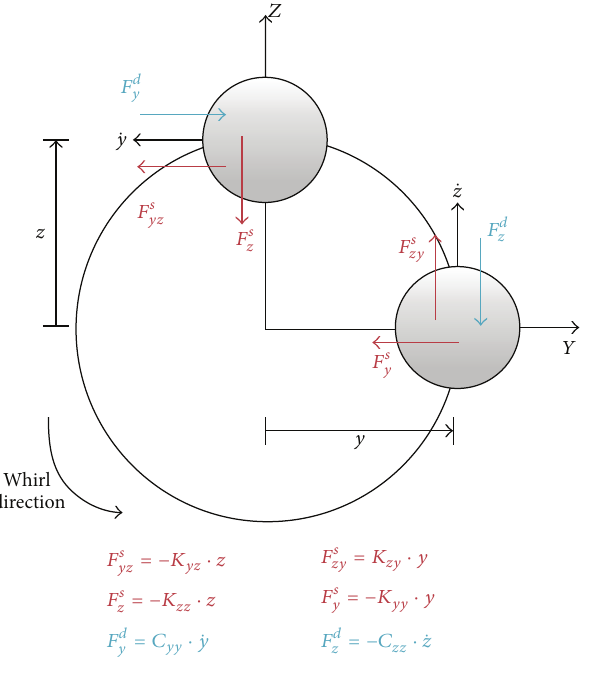
Figure 12: Representation of the forces acting on the shaft inside the journal